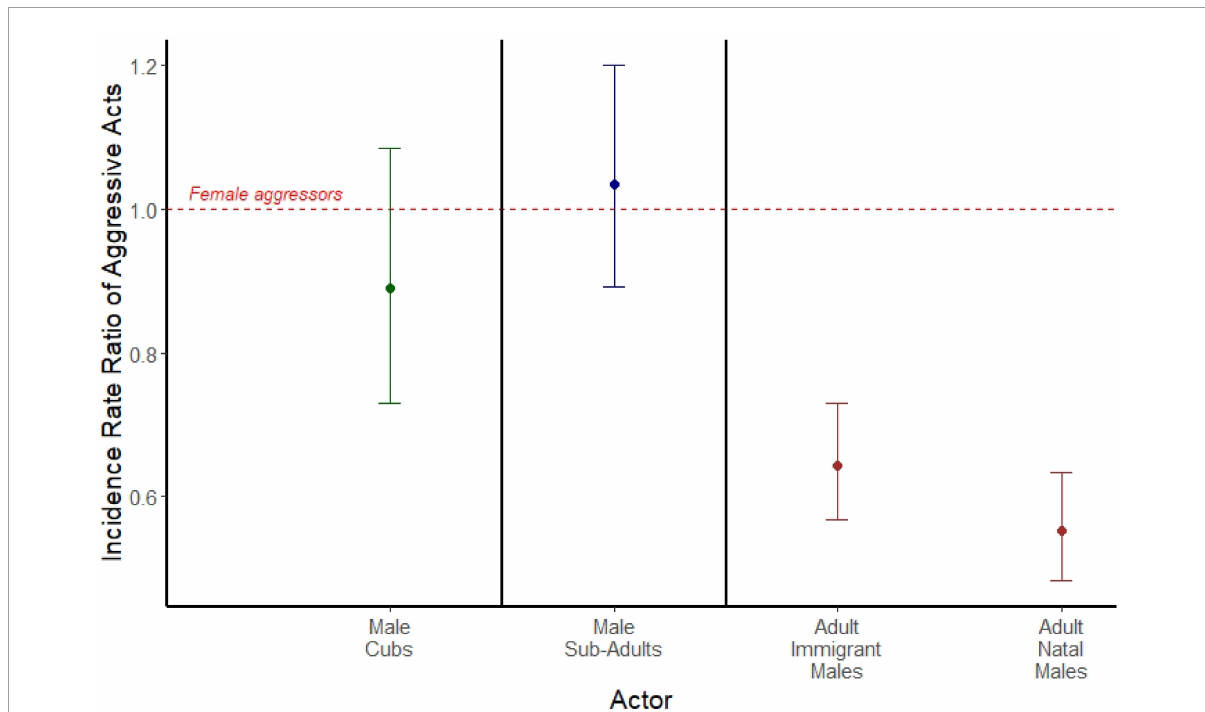
FIGURE1 Incidence rate ratios of spontaneous aggressive acts emitted by male cubs (green), male subadults (blue), adult immigrant males (brown), and adult natal males (brown). Each is compared to a female aggressor reference group of the same age class, represented by the red dashed line. Points represent the estimated incidence rate ratios from three separate mixed models separated by bold black lines (actors who are cubs, actors who are subadults, and actors who are adults), and error bars represent 95% confidence intervals around the incidence rate